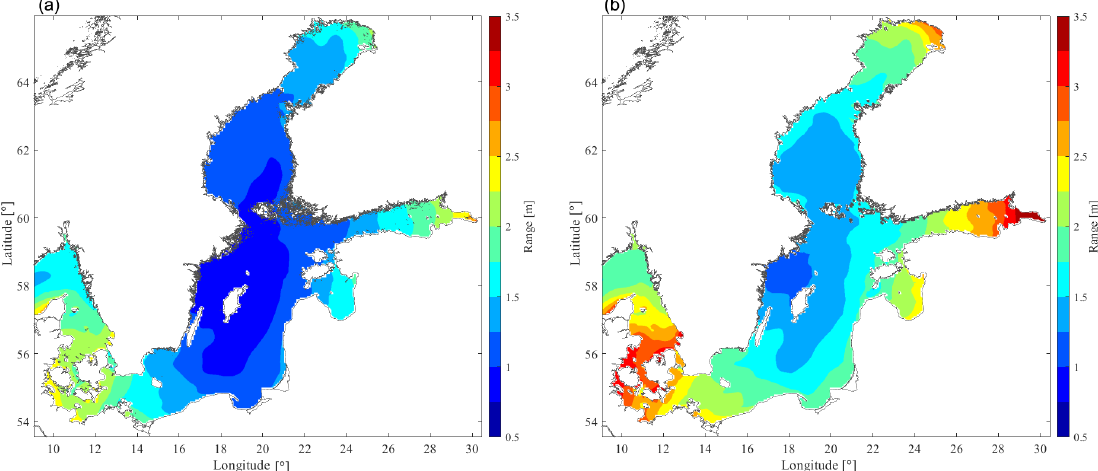
Figure 5. (a) Average MSSHR y – average annual maximum ranges over the 10-year window. (b) MSSHR 10y – decadal maximum ranges over the 10-year window. The colour scale is different from the one in Fig. 4 for ease of readability and